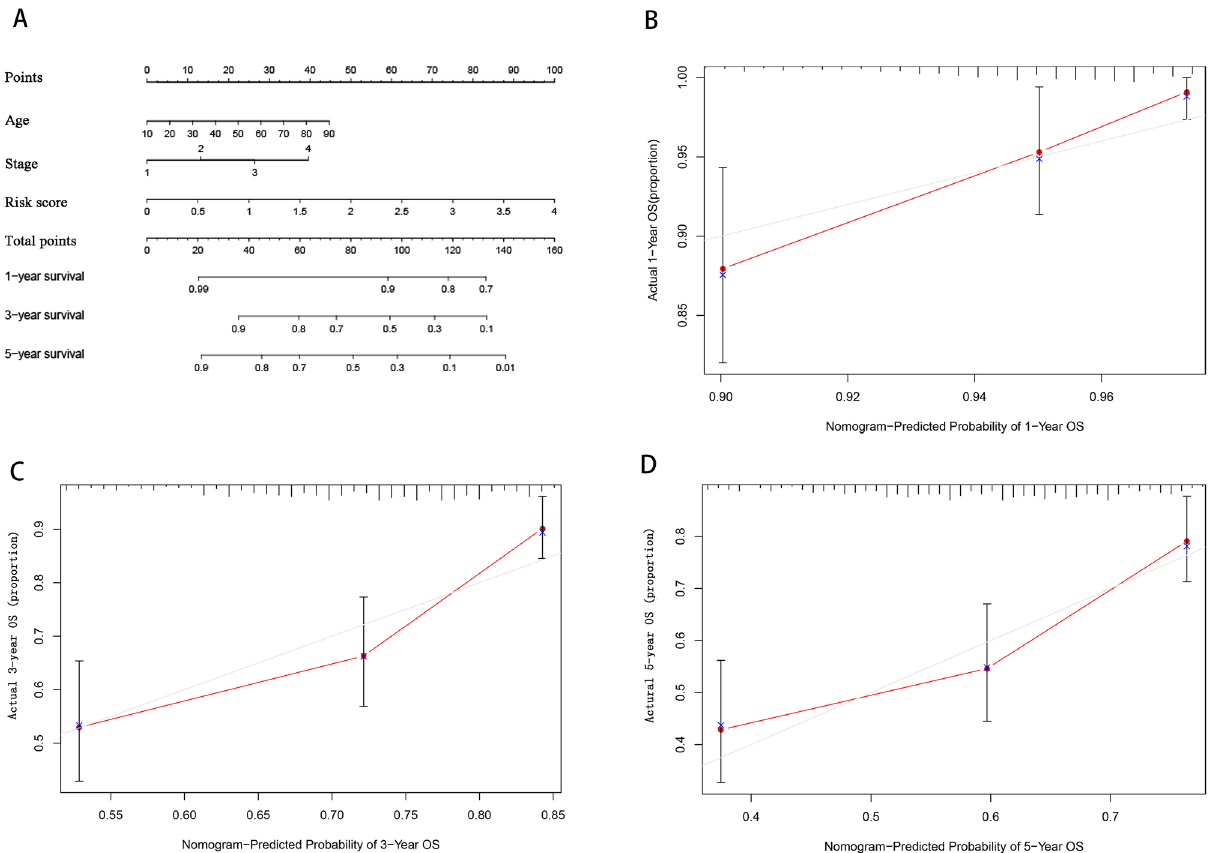
Figure 6. Nomogram development and evaluation. ( A ) a nomogram on the basis of age, stage, and risk score predicts melanoma patients’ prognosis. ( B–D ) Calibration curves for predicting overall survival in melanoma patients at 1 year ( B ), 3 years ( C ), and 5 years ( D